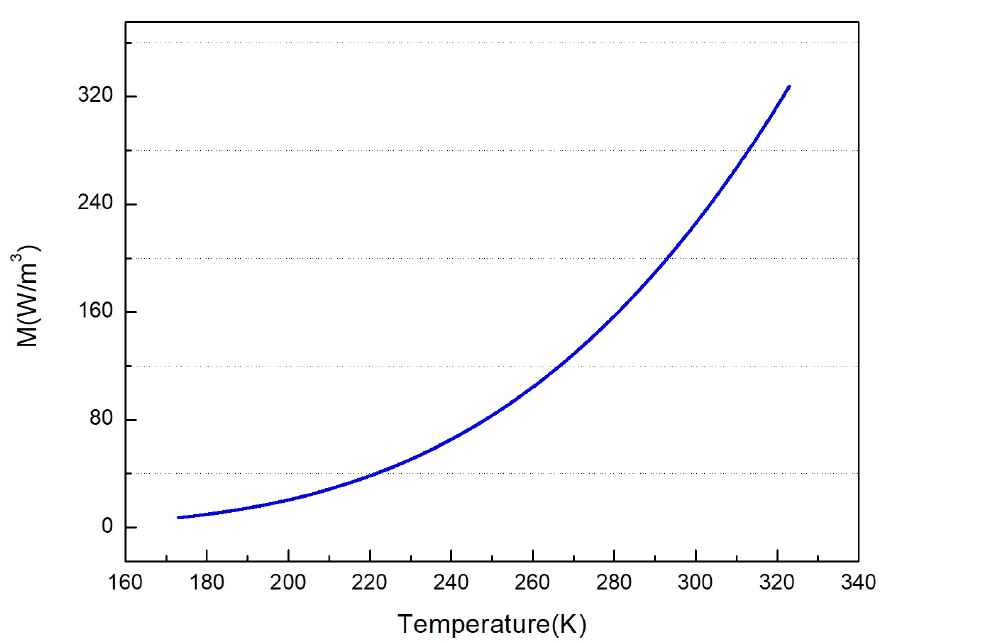
Figure 1. Theoretical relationship between temperature and radiation